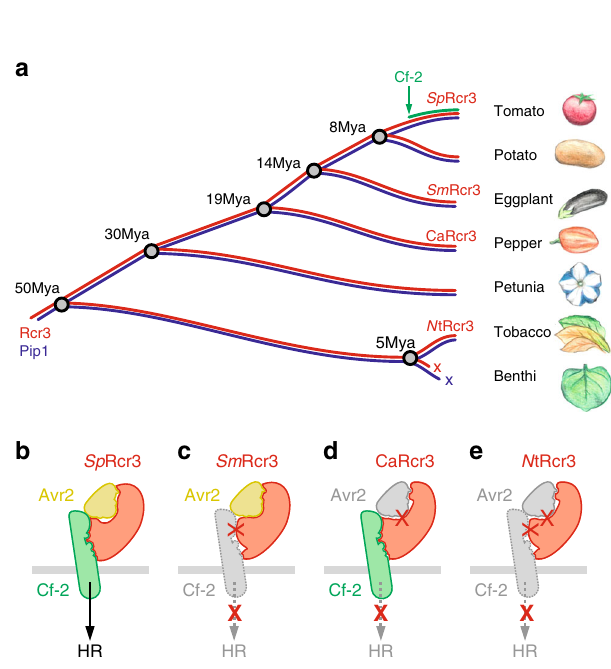
Fig. 8 Model for evolution of Rcr3. a Cf-2 evolved in wild tomato